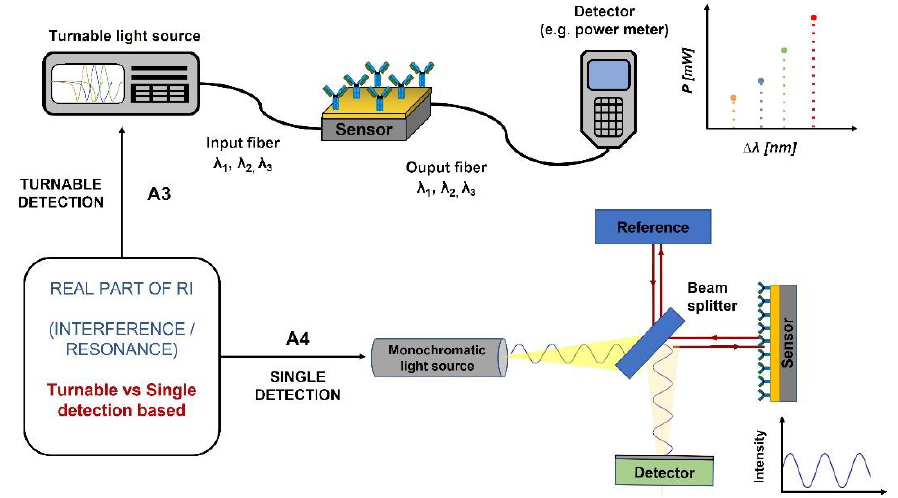
Figure 10. Classification based on the monitored changes in the real part of the refractive index. A3 — Turnable Detector Based by using a turnable laser; and A4 — Single Detection Based by a Michelson Interferometer.